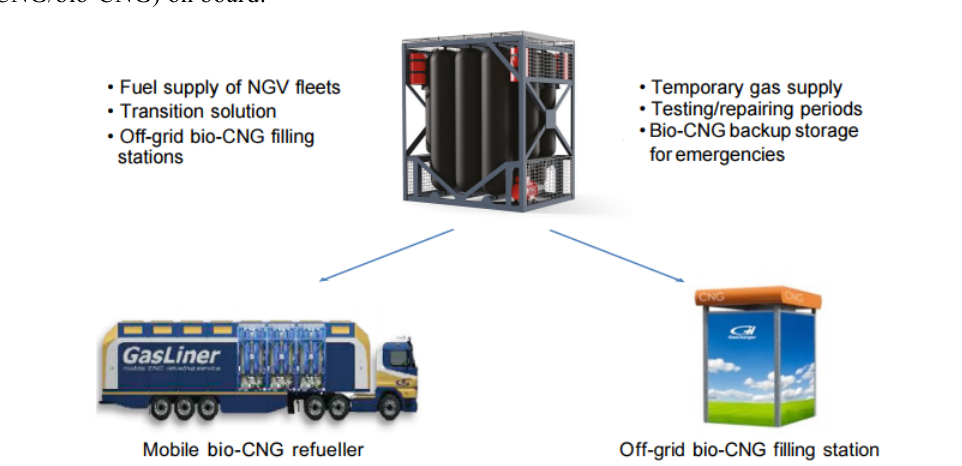
Fig. 8. GasLiner modules in mobile and stationary